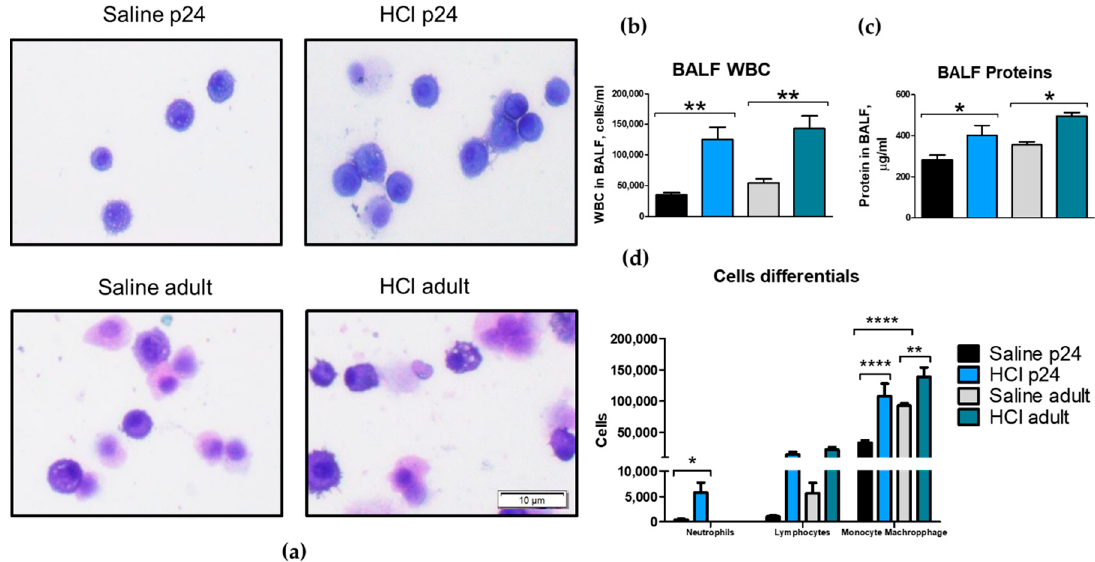
Figure 1. Alveolar inflammation persists in both young and adult mice. ( a ) Microscopic evaluation of bronchoalveolar lavage fluid (BALF) cells revealed monocyte − macrophage infiltration. ( b ) Total cell count, ( c ) total protein concentration, and ( d ) cell differentials. Young p24 and adult mice were instilled with 2 µL/g 0.1 N HCl. Original magnification 100×, scale bars 10 µM. Means ± SEM, n = 3–5, * p < 0.05; ** p < 0.01; **** p < 0.0001 with one-way ANOVA and Tukey’s test.